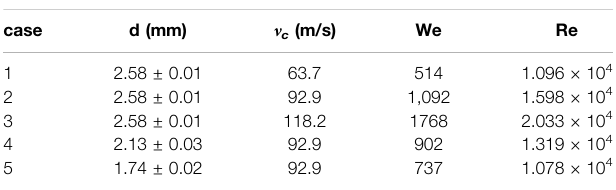
TABLE 1 | Parameters of fi ve experimental conditions.